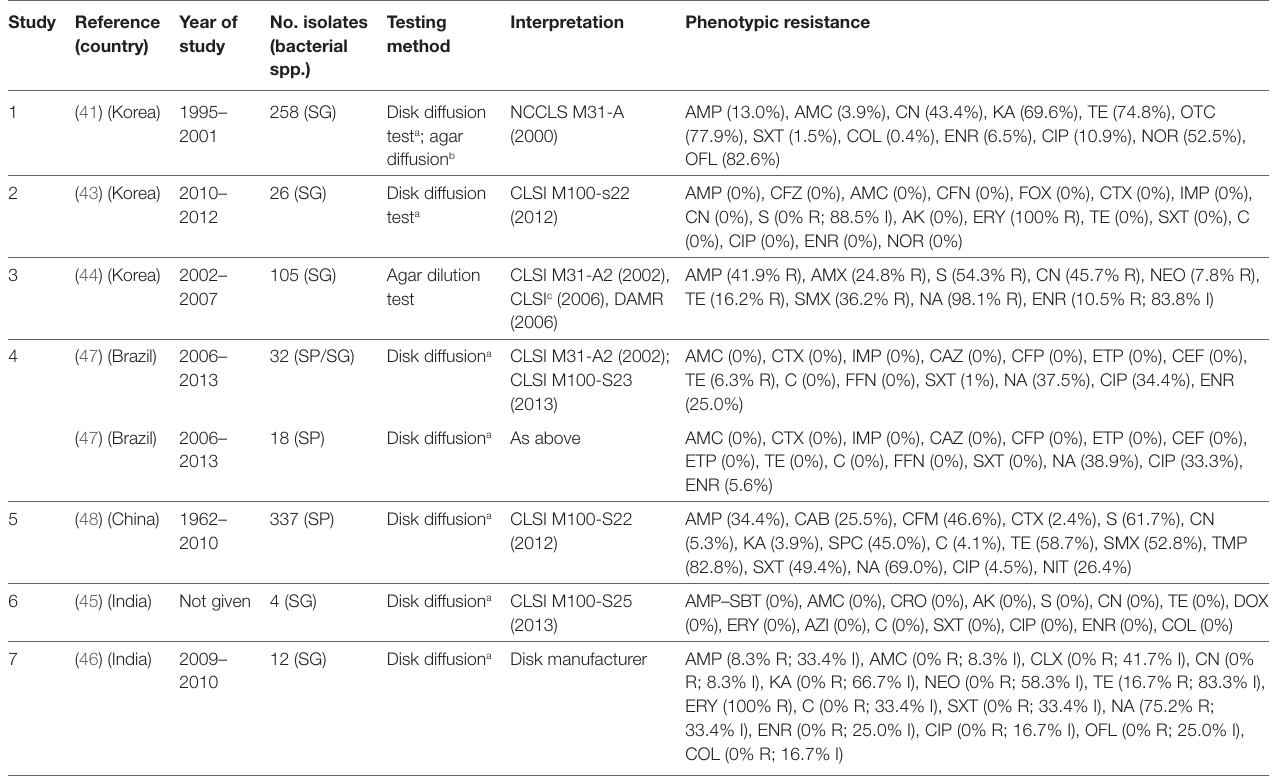
TABLe 2 | Summary of results of 7 phenotypic studies on antimicrobial resistance of S . Pullorum/Gallinarum from poultry. Study Reference